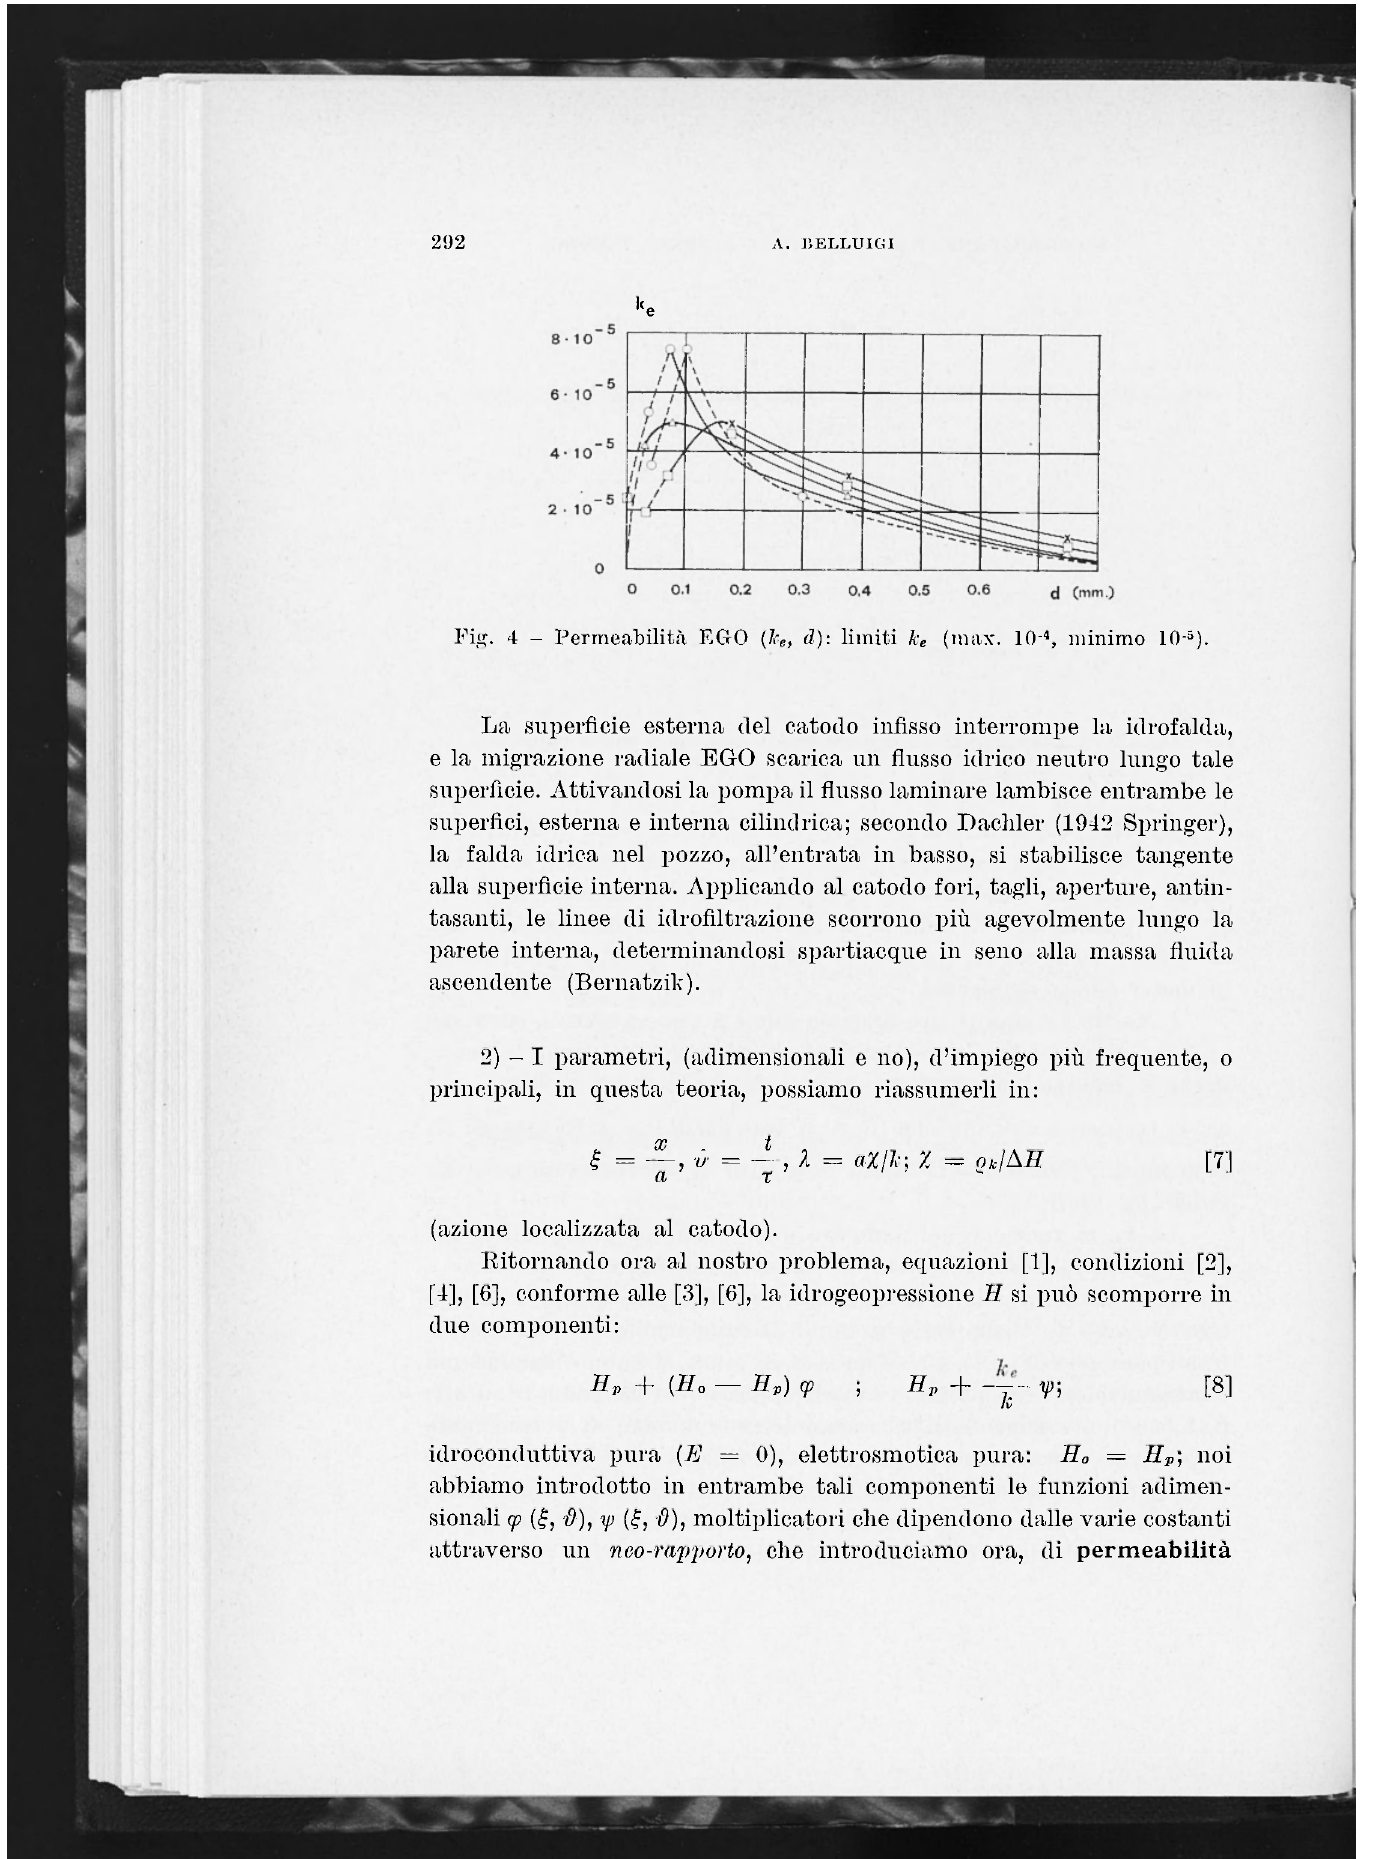
Fig. 4 - Permeabilità EGO (k e , d): limiti k e (max. IO" 4 , minimo IO- 5